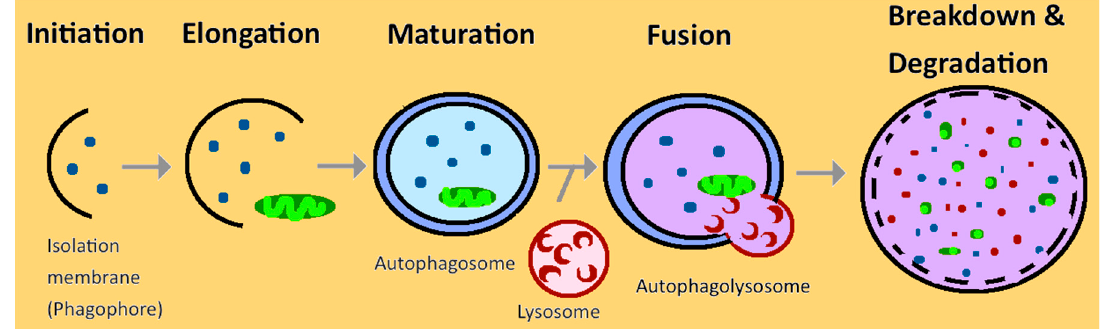
Figure 1. Schematic overview of the normal autophagy function in the kidney. Multiple steps in autophagy are modulated in kidney diseases, including autophagy initiation, elongation, maturation, fusion, and final degradation and recycling.